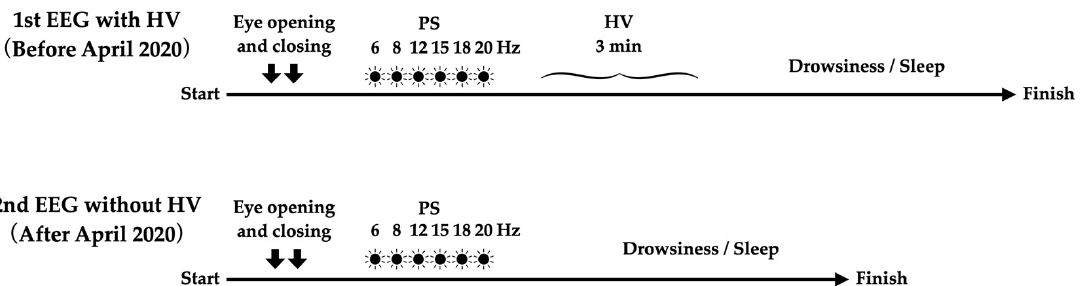
Figure 1. Flow of EEG examination. In our institution, HV was routinely performed before the COVID-19 outbreak, but was omitted after April 2020.